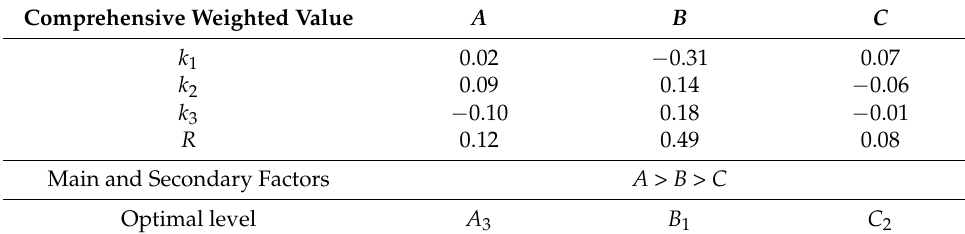
Table 5. Range analysis of comprehensive scores.